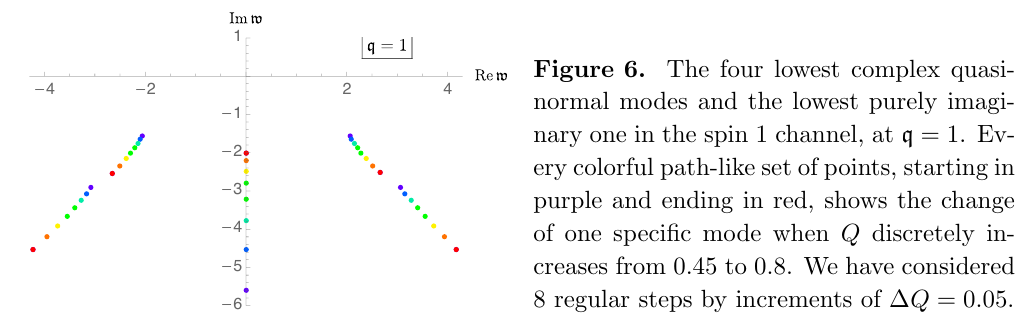
Figure 5. Quasinormal modes associated with Q = 0 : 5 at two di(cid:11)erent values of q , in spin 1 channel. At each value of q , we have shown (cid:12)ve lowest quasinormal modes. As q decreases, all poles stay at (cid:12)nite distances from the real axis. The latter manifests the non-existence of any spin 2 hydrodynamic mode in N = 4 SYM theory at (cid:12)nite chemical potential.